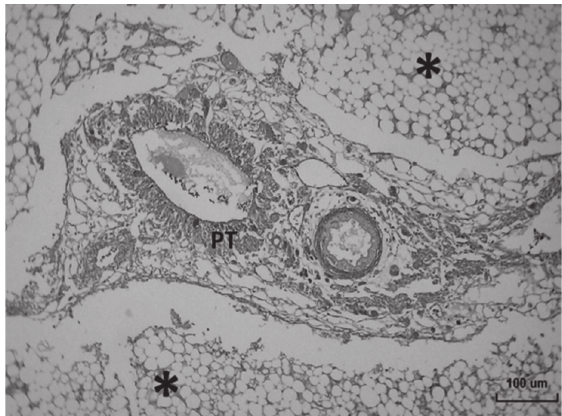
Figure 1 - Gobioides grahamae . Light photomicrograph of a liver specimen, showing the disorganization of the threads of hepatocytes, and the marked intracytoplasmatic vacuolization of the cells (*), which is typical of diffuse steatosis. Note the presence of intra-hepatic pancreatic tissue (PT). Masson’s trichrome staining. Scale bar = 100